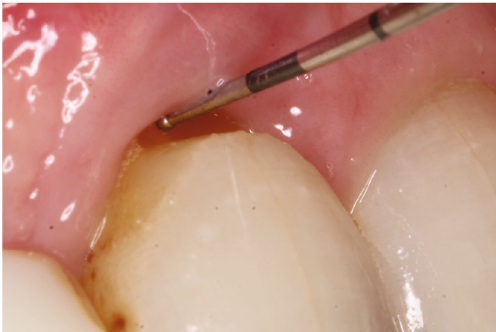
Figure 10: Intraoral view shows cervical recession of 2 mm on tooth 11.